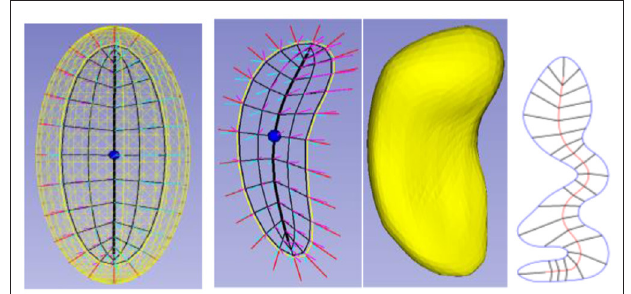
FIGURE 3 | Skeletal models. Left: Ellipsoid (3D) with its elliptical skeleton (grid), spine (bold), and center point (bullet). Middle left: A skeleton and its spokes for the hippocampus (3D) shown in middle right. Only samples of the spoke vectors are shown, but they exist continuously, i.e., with their tails at every continuous point of the skeletal surface. Right: A skeleton (red) and its spokes for a 2D object.